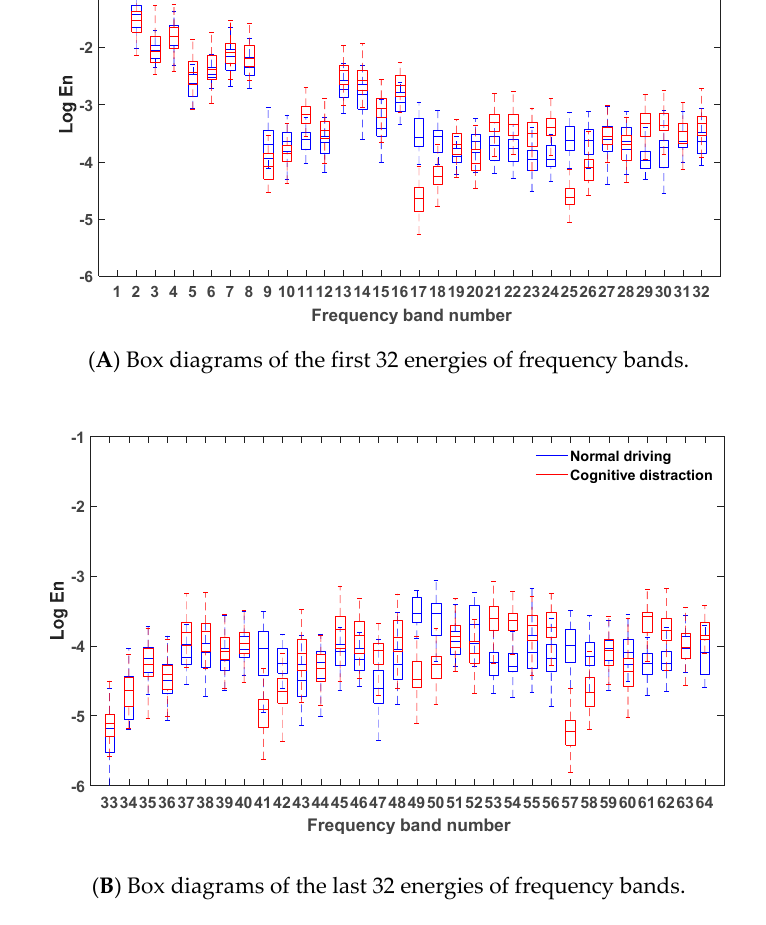
Figure 9. Box diagrams of the energies of frequency bands under different driving states.